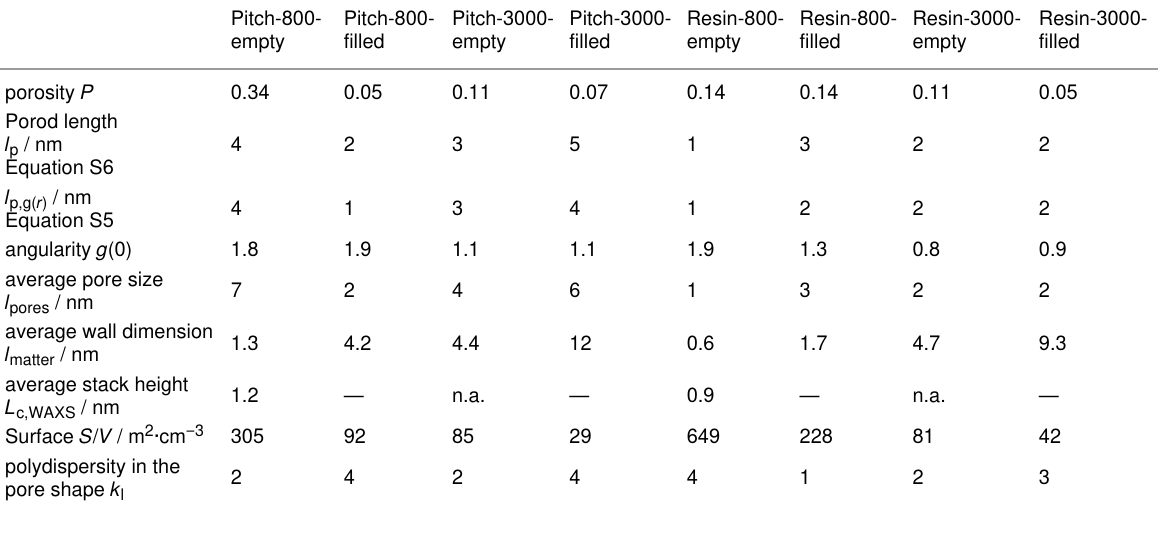
Table 1: Summary of SANS analysis and SANS-derived porosity parameters for the different samples under